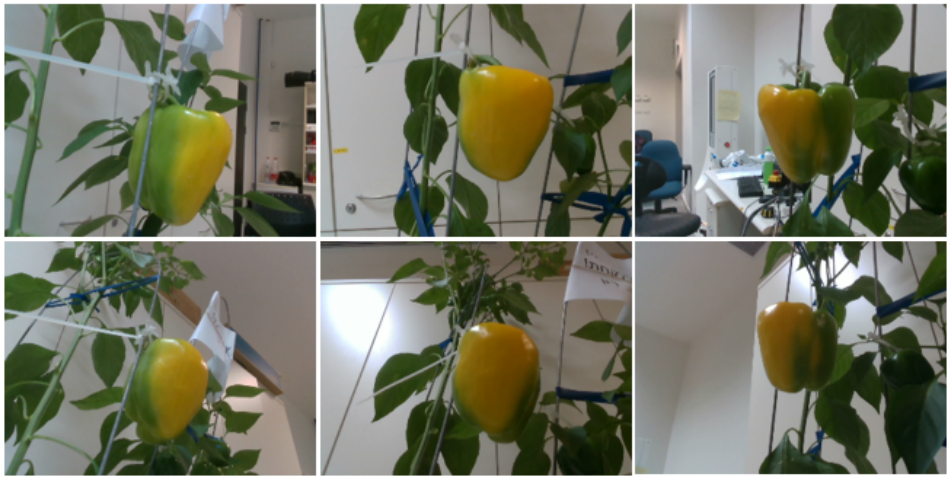
Figure 1. Six different sides of the same pepper; some parts can be green while other parts are fully